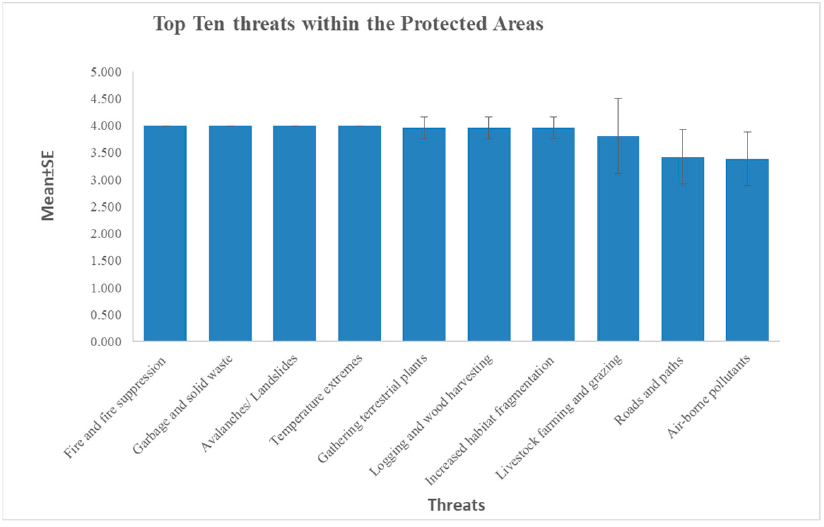
Figure 7. Dynamics of major threats among 26 PAs in Pakistan where Western Tragopan occurs.